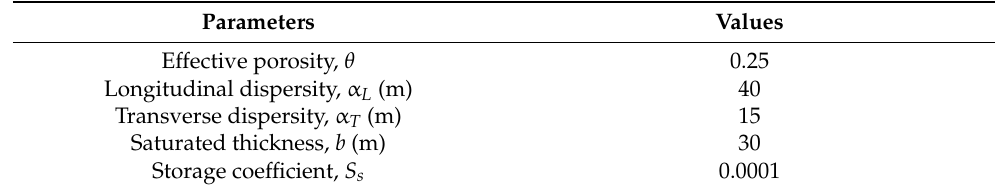
Table 7. Hydrogeological parameters of case 2.